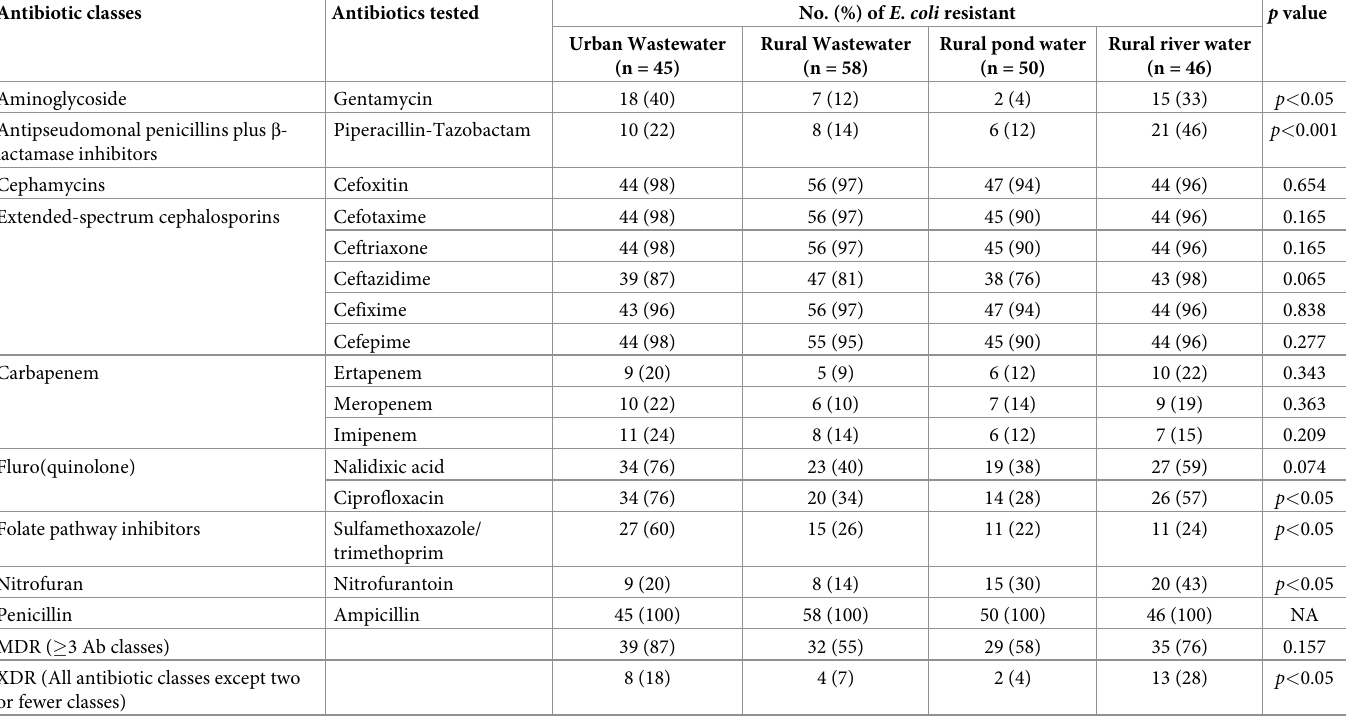
Table 3. Occurrence of clinically important antibiotic resistance among PMQR-positive E . coli isolates from aquatic environments in